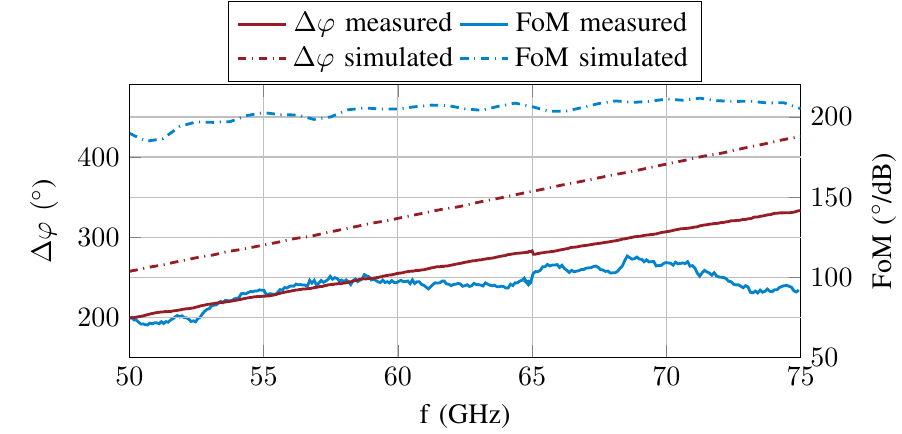
Figure 23. Differential phase shift and FoM of the PPDW phase